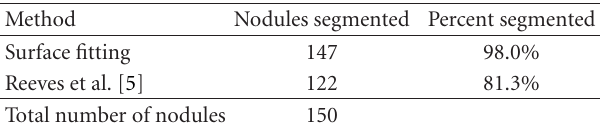
Table 2: Nodule segmentation results comparing the surface-fitting method described in this paper with a previously published method using a plane-cutting approach.